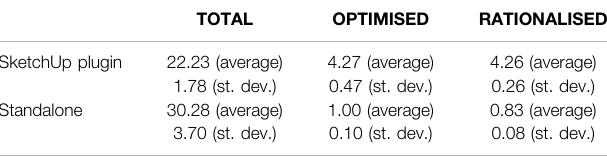
TABLE 5 | Computing times of the SketchUp plugin and standalone version